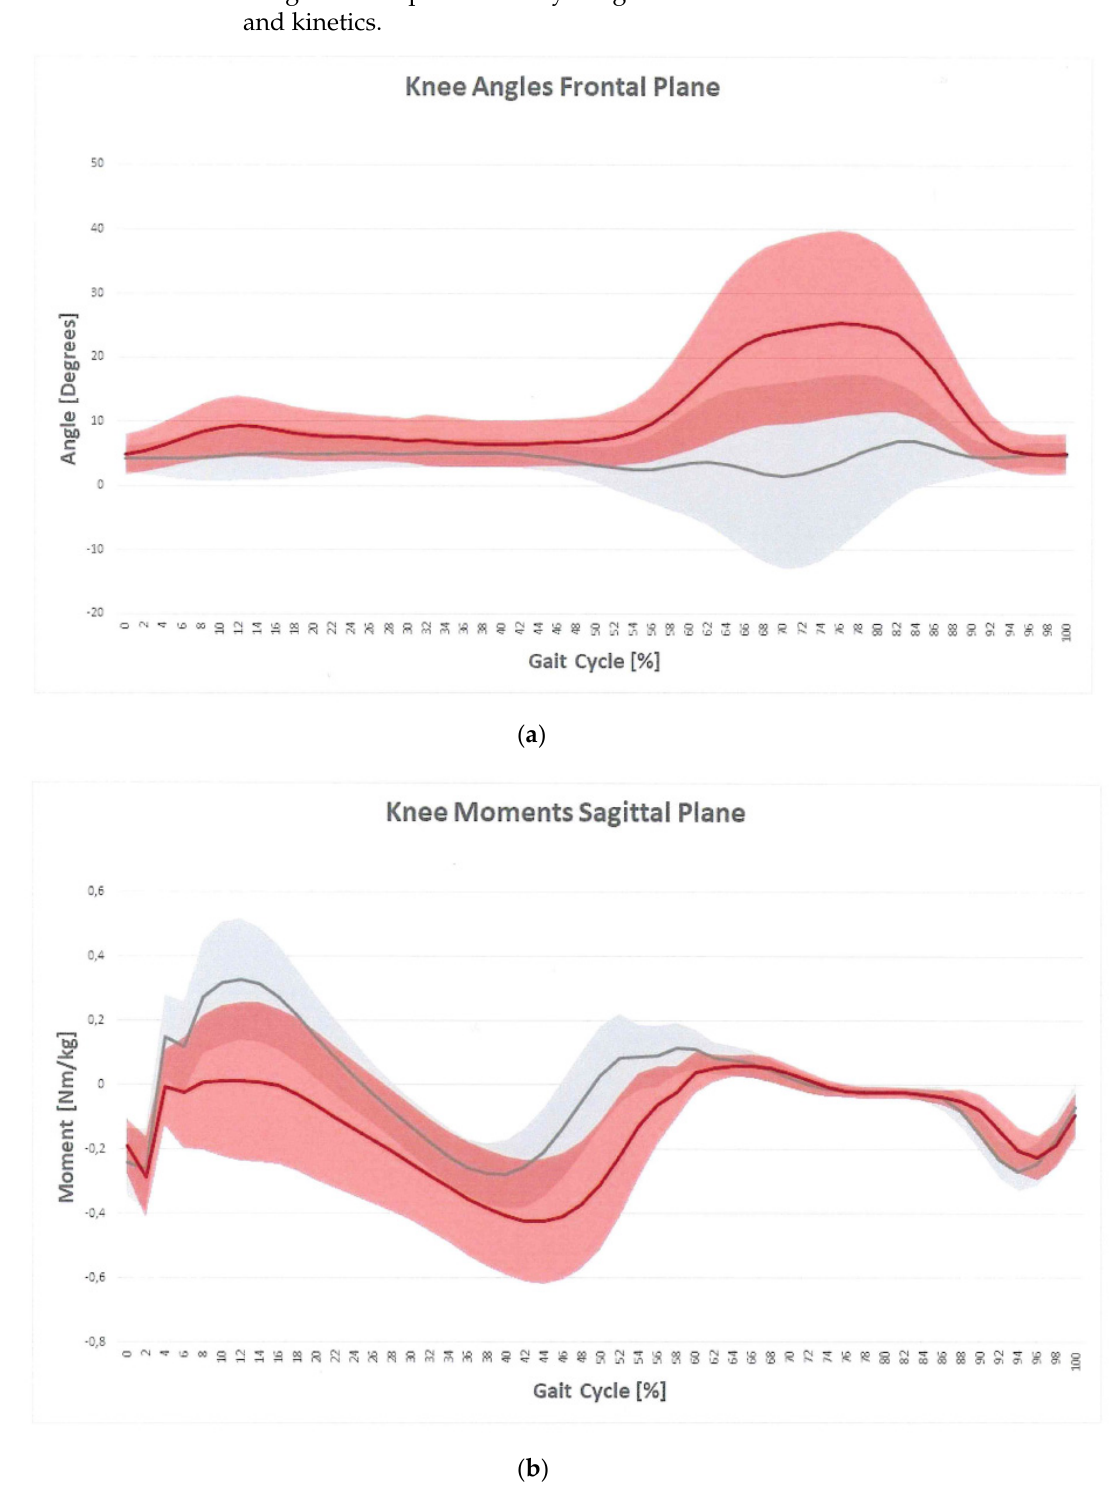
Figure 2. Knee angles plot on frontal plane ( a ) and knee moment plot on sagittal plane ( b ) for OG (red) and CG (gray). The vertical line is representative of